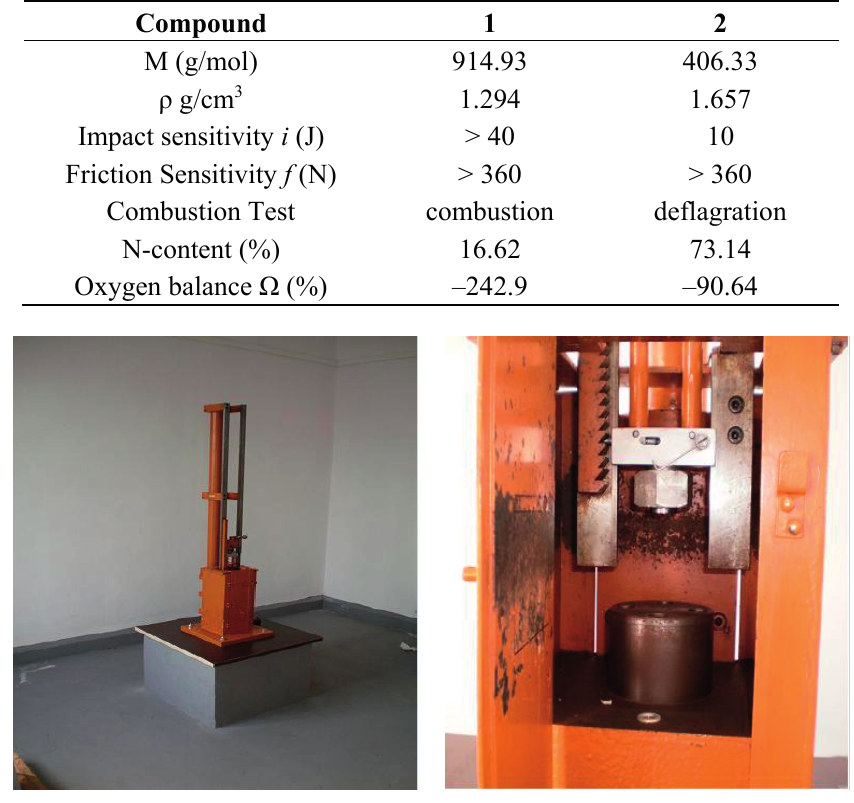
Figure 10. BAM drophammer setup used in this study.